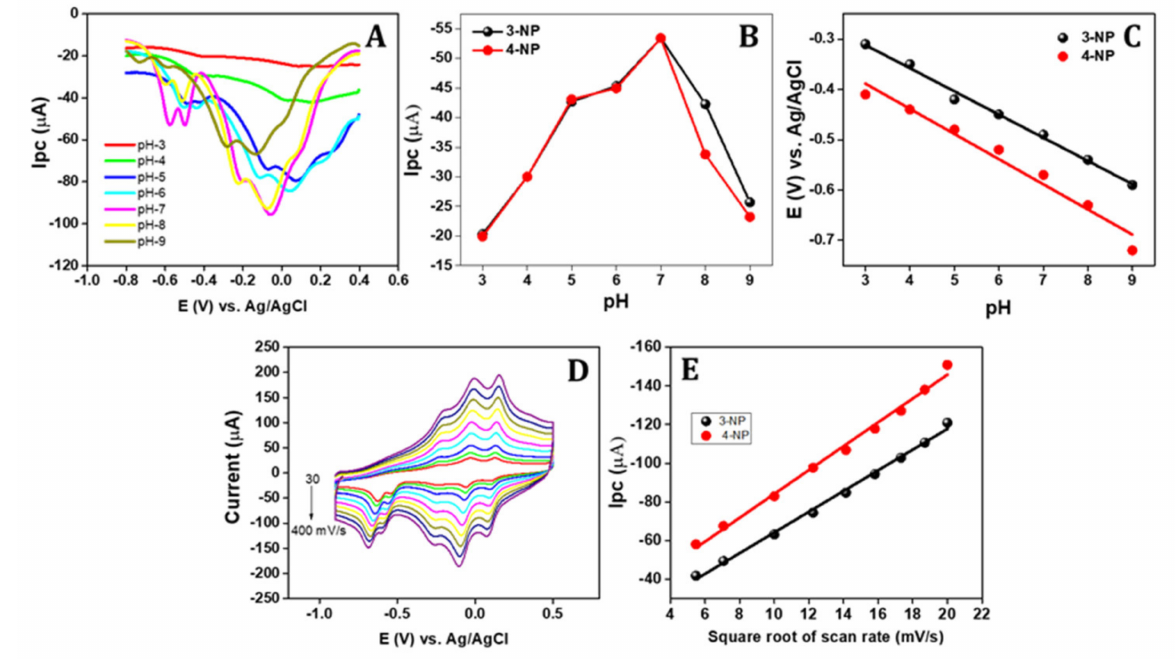
Figure 4. ( A ) Influence of different pH condition (pH-3 to pH-9) on sensing (20 µ M) of 3-NP and 4-NP; ( B ) the relationship between pH vs. cathodic peak current of both 3-NP and 4-NP; ( C ) the relationship between pH vs. cathodic potential shift of both 3-NP and 4-NP; ( D ) the influence of different scan rates (30 to 400 mV/s) in the presence of 20 µ M of 3-NP and 4-NP in 0.1 M PBS; and ( E ) the relationship between the square root of scan rate vs. cathodic peak current of 3-NP and